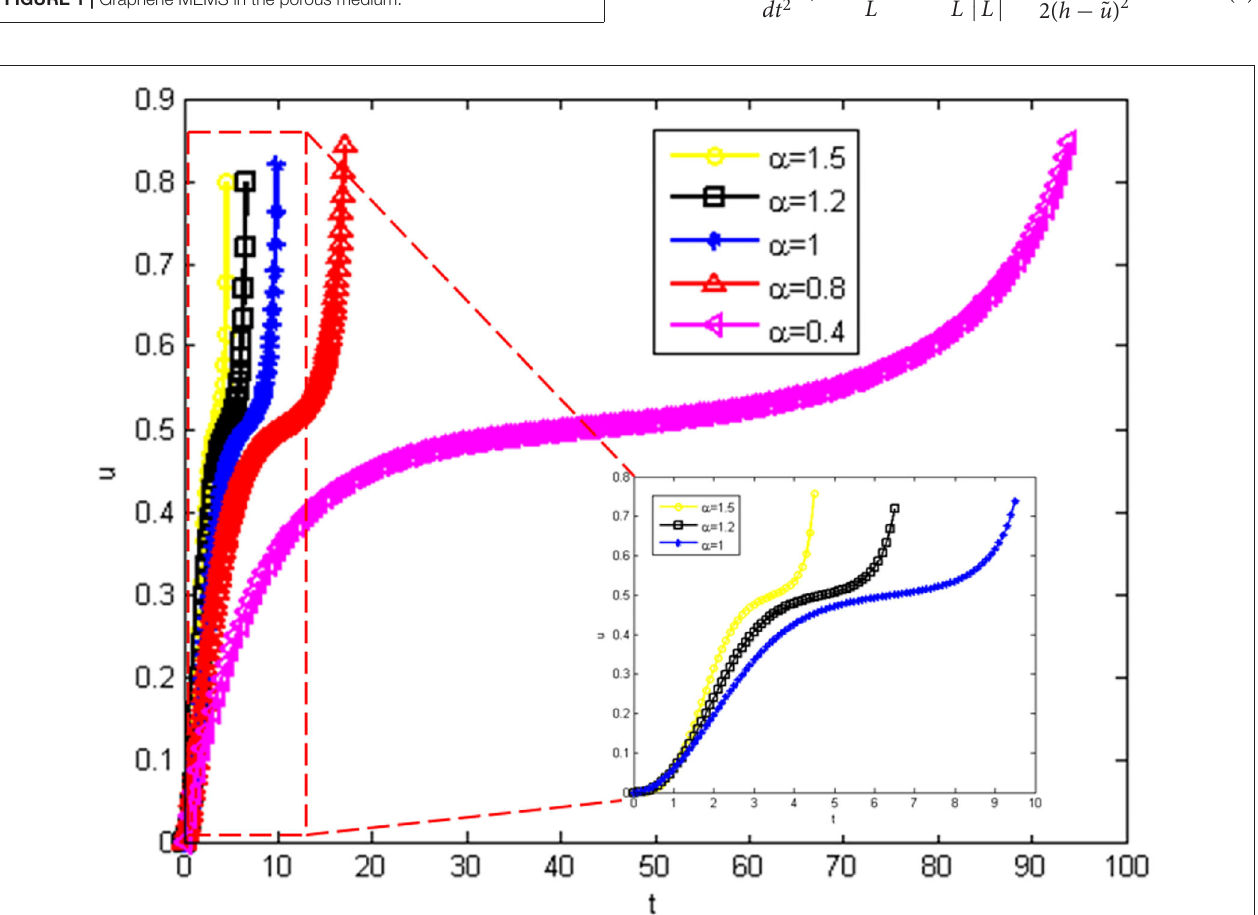
FIGURE 2 | Pull-in instability for different values of α and k =